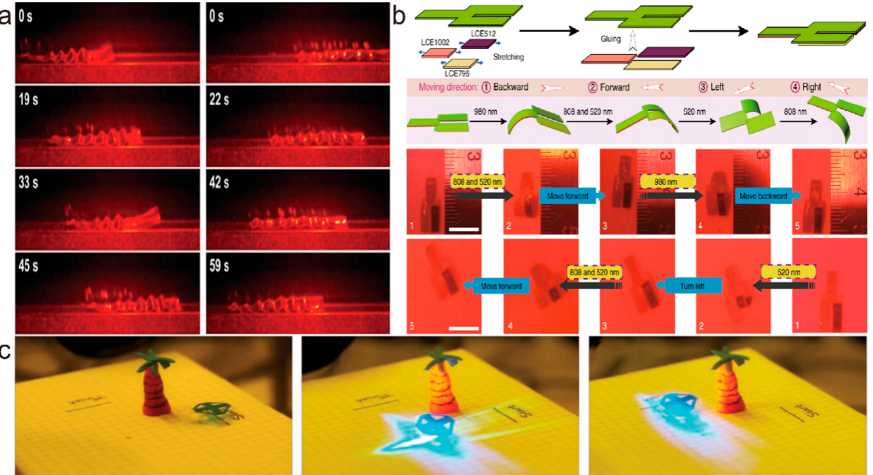
Figure 11. ( a ) A soft robot moving forward and backward under a continuous wave green laser (Reprinted with permission from Ref. [86]. Copyright 2016, John Wiley and Sons). ( b ) Schematic diagram of a multi-directional soft robot, and images of it crawling under three wavelengths of light (Reprinted with permission from Ref. [7]. Copyright 2019, Springer Nature). ( c ) A light-driven soft robot moving around (multi-directional) a palm tree (Reprinted with permission from Ref. [91]. Copyright 2020, John Wiley and